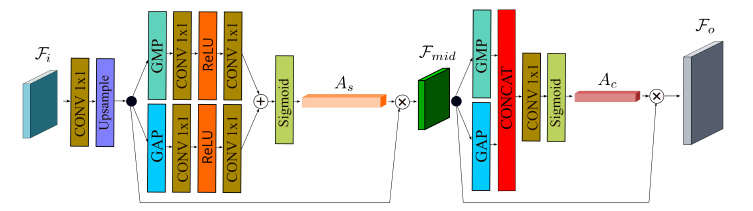
Figure 8. The archiecture of